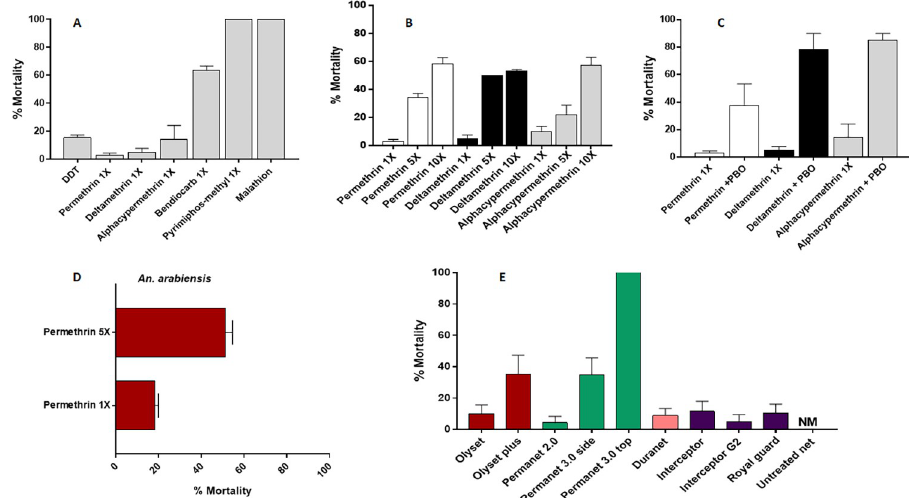
Fig 1. Susceptibility profile of An . gambiae s . l population from Mayuge. A) susceptibility profile of females An . gambiae ; B) resistance intensity with 5 × and 10 × the diagnostic concentrations of permethrin and deltamethrin and Alphacypermethrin C) effect of pre-exposure to synergist PBO against pyrethroids. D) Susceptibility profile and intensity of females An . arabiensis and E) bio-efficacy of different commercial LLINs against An . gambiae . Results are average of percentage mortalities ± SEM; Results are average of percentage mortalities from four replicates each ±